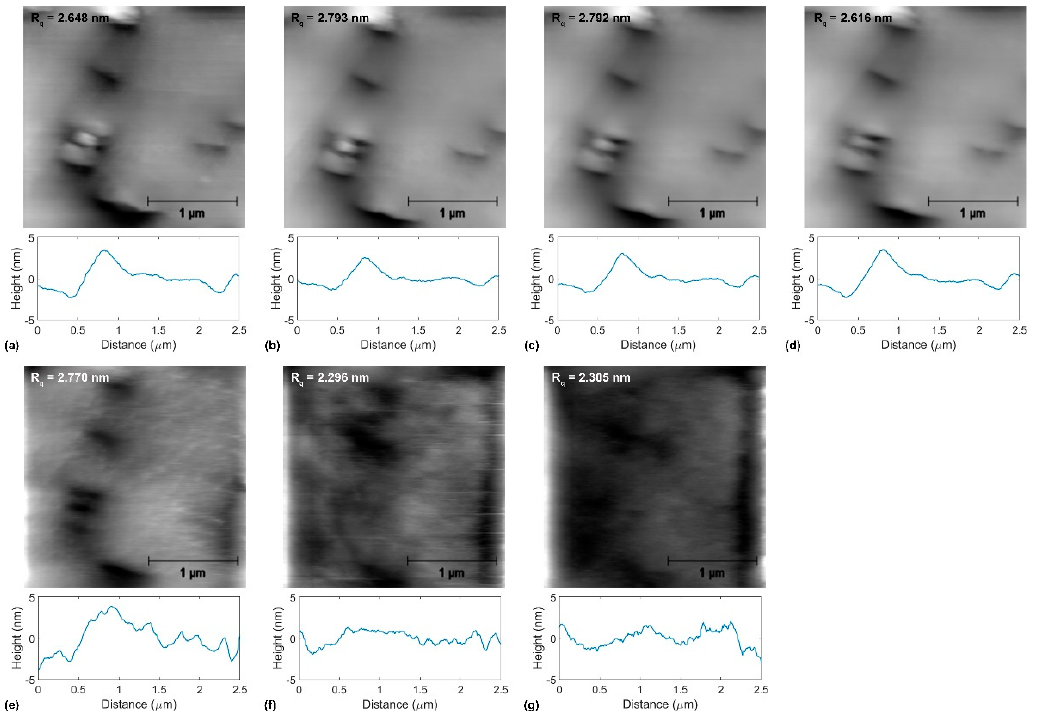
Figure 6. Topographical evolution during tribological tests of boron nitride (BN)-coated copper at the normal force values ( a ) F n = 153 nN, ( b ) F n = 616 nN, ( c ) F n = 1232 nN, ( d ) F n = 2310 nN, ( e ) F n = 3850 nN, ( f ) F n = 5390 nN, and ( g ) F n = 6930 nN. In ( a – g ), the AFM topographical images at the normal force values indicated above, the corresponding roughness parameter R q -values, and representative line scans are presented.